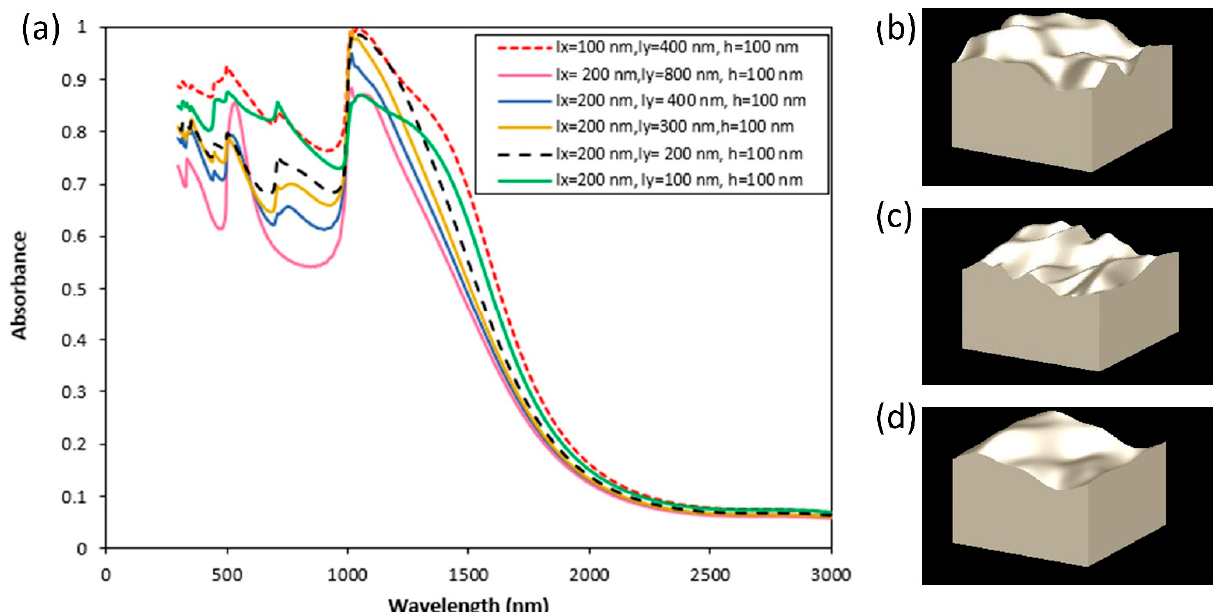
Figure 7. ( a ) The effect of correlation length for the W anisotropic rough surface. ( b ) Isotropic rough surface with l = 200 nm and h = 100 nm. ( c ) Anisotropic rough surface with l x = 100 nm, l y = 400 nm, and h = 100 nm. ( d ) Anisotropic rough surface with l x = 200 nm, l y = 400 nm, and h = 100 nm.